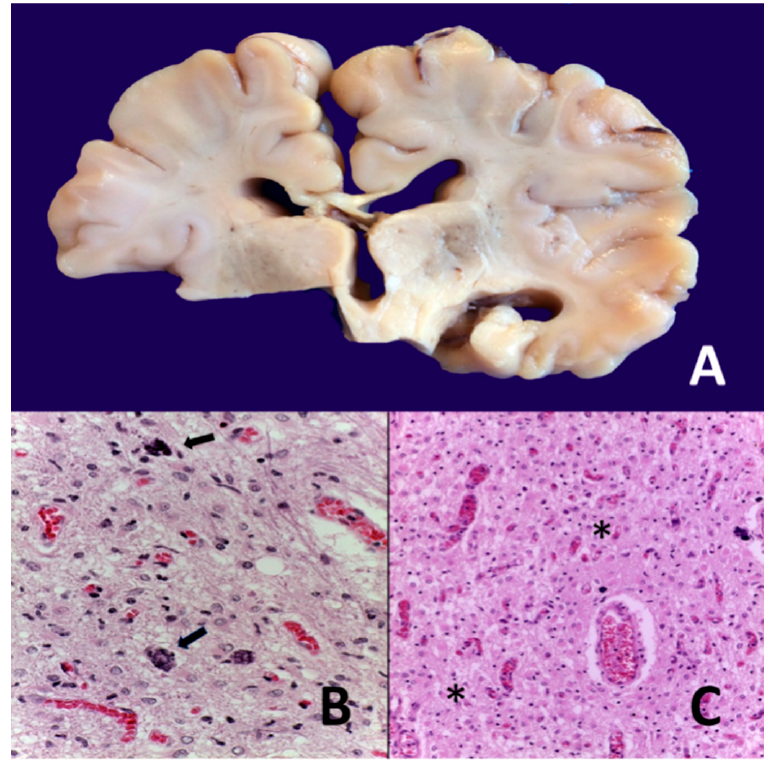
Figure 5. ( A ). Bilateral basal ganglia necrosis in a male at 39.6 weeks gestation with severe perinatal asphyxia secondary to congenital heart disease. ( B ). Neuronal necrosis and calcification (arrows). of Pathology, Hospital Infantil de México Federico Gómez).